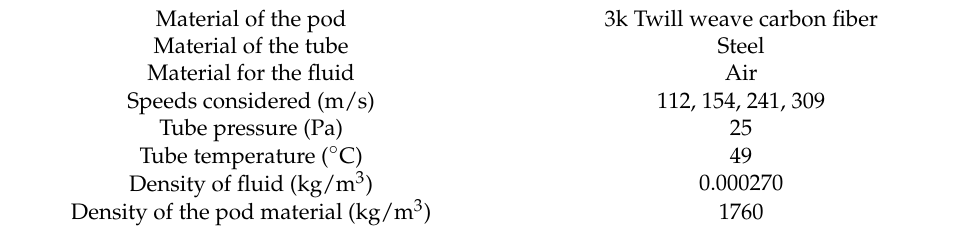
Table 2. Boundary conditions used for the computational models.